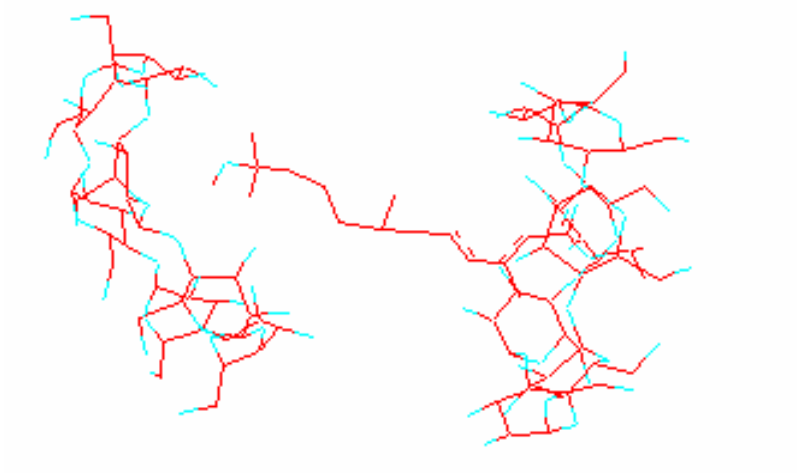
Figure 5. Equilibrium configuration of the BCD2-methoprene complex after dynamic simulation.